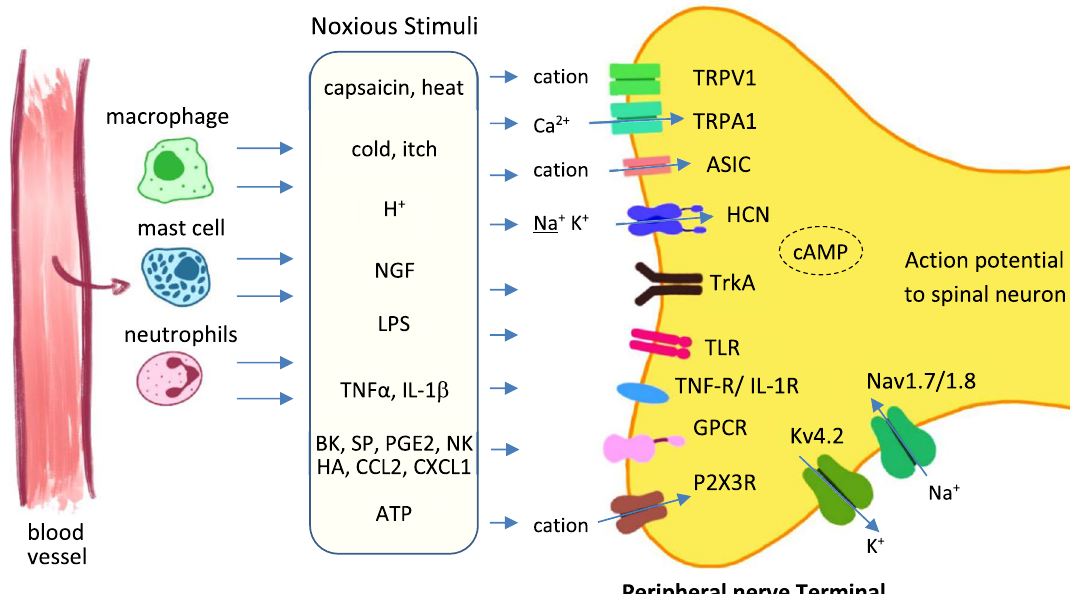
Fig. 1 Peripheral sensitization. Activation of peripheral nociceptors on the skin in response to stimuli, such as heat, injury or mechanical pressure, initiates the release of chemical mediators at the site of injury (peripheral sensitization). Peripheral terminals respond to noxious stimuli through ion channels such as TRP, ASIC, HCN, and P2X receptors, as well as TrkA, TLR, TNFR, IL‑1R and GPCRs such as bradykinin (BK), neurokinin (NK) which indirectly modulate ion channels and intracellular signaling pathways. When a threshold depolarization is reached, voltage‑gated sodium channels (Nav1.7/1.8) are activated, which generate an action potential. At this point voltage‑gated potassium channels (Kv4.2) open and repolarize the membrane, while Na V channels close and the neuron returns to a resting state. The action potential then propagates along the axon to the spinal neuron. TRP transient receptor potential, ASIC acid sensing ion channels; HCN hyperpolarization‑activated cyclic nucleotide‑gated channel, P2X3R purinergic receptor 3, TrkA tropomyosin receptor kinase A, CCL2/ CXCL1 chemokines, PGE2 prostaglandin 2, TNF tumor necrosis factor, IL-1R interleukin 1 receptor, TLR toll‑like receptor, GPCR G protein‑coupled